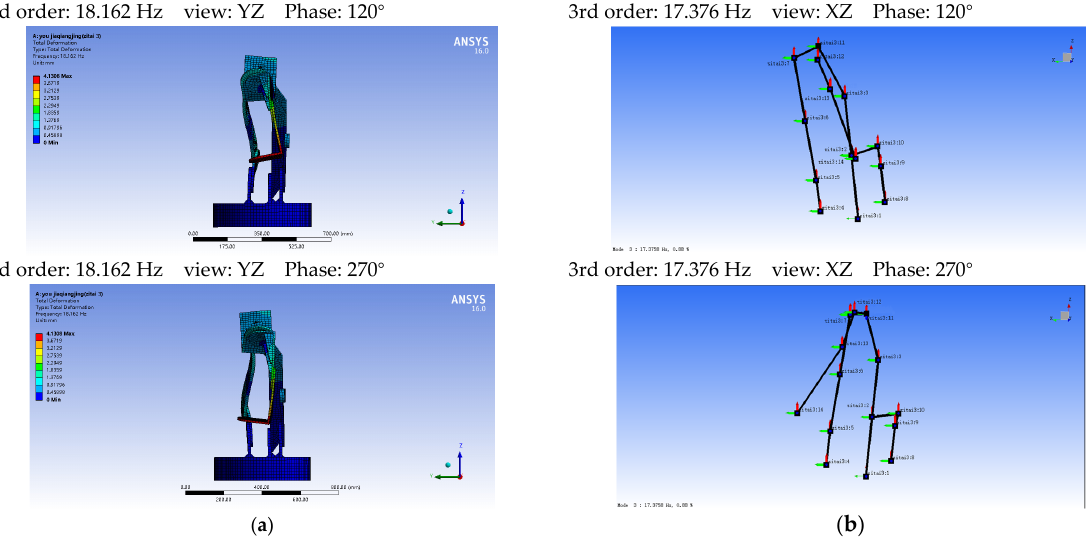
Figure 5. ( a ) Third-order simulation mode diagram; ( b ) Third-order test mode diagram.